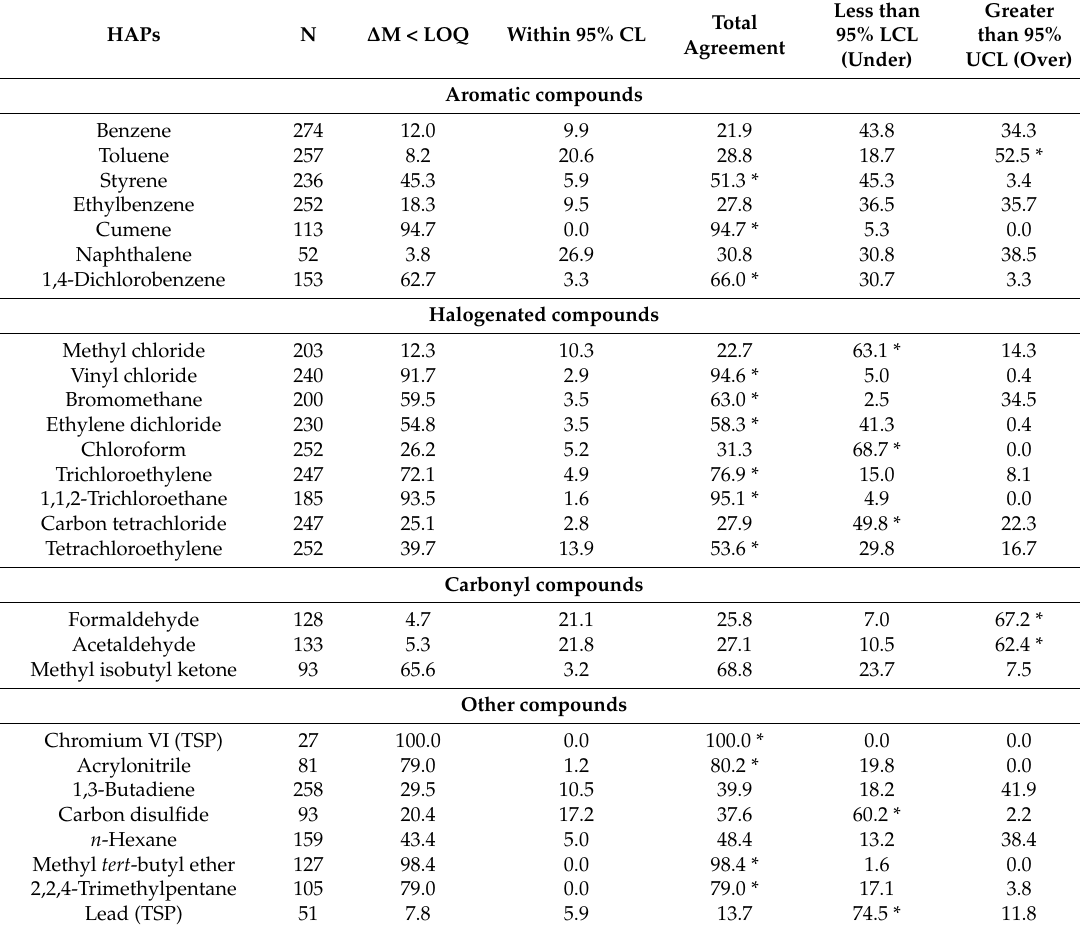
Table 3. Percentages of agreement, underestimation, and overestimation sites determined by NATA-AQS comparisons.